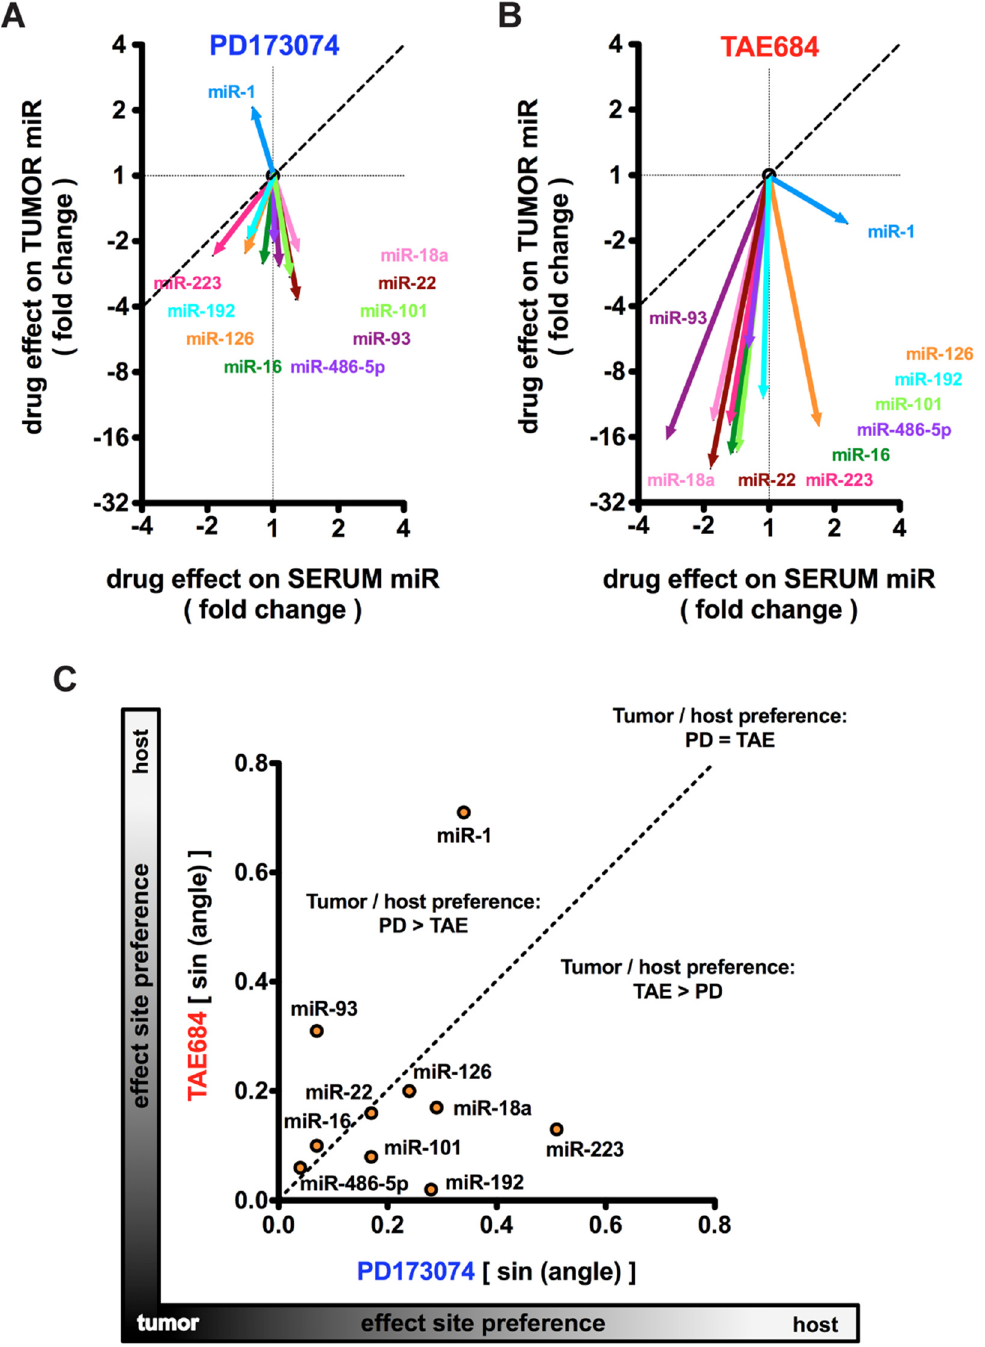
Figure 5. Comparison of serum and tumor miR expression in COLO357PL xenograft mouse model. ( A , B ): PD173074 ( A ) or TAE684 ( B ) treatment-induced changes of miRs in serum and tumor samples relative to vehicle treatment. The vectors indicate the fold change of expression in the serum ( x -axis) and tumor ( y -axis) samples harvested at the same time. qPCR for miRs in serum samples were run in duplicates on previously pooled serum samples of mice that belonged to the same treatment group ( n = 6 and 7 serum samples per treatment group); tumor samples were analyzed separately for miR expression ( n = 7 and 8 tumors per treatment group). The dotted line indicates identical changes in tumor and serum. ( C ): Tumor or host (serum) preferential effect site for PD173074 versus TAE684 treatment. The sine of the direction of each miR change vector in panels ( A , B ) are plotted. The dotted line indicates identical preference of TAE and PD for the respective miR.